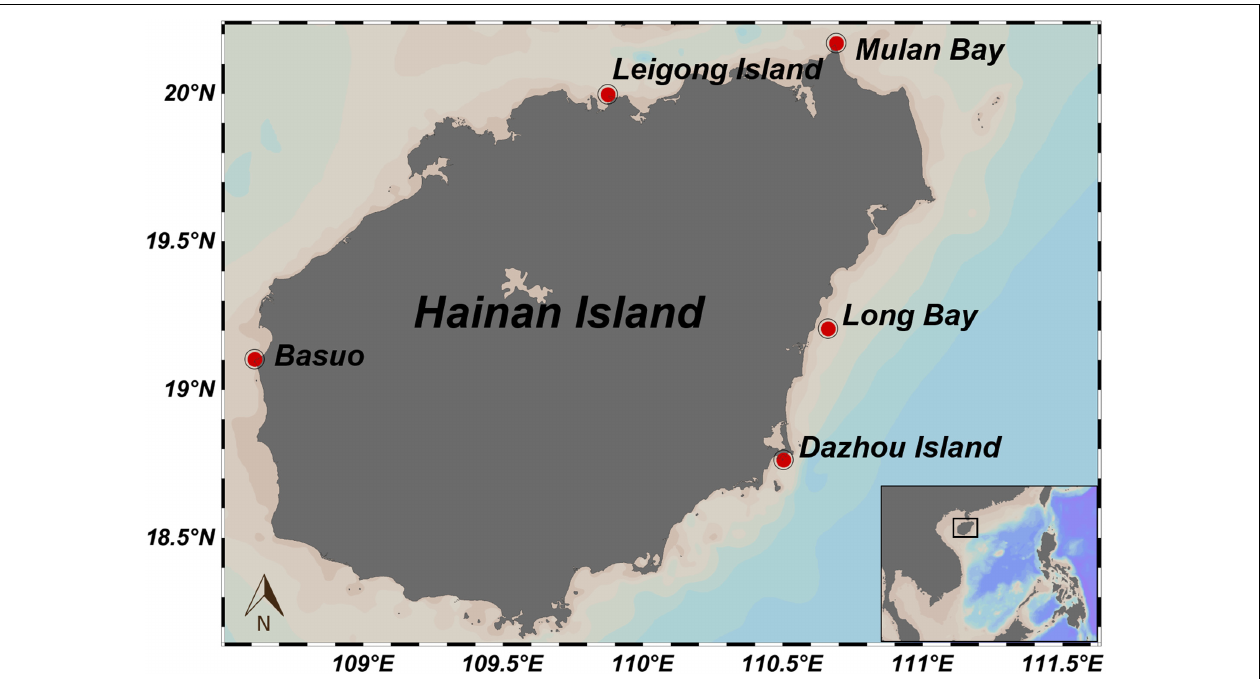
FIGURE 1 | A geographic map showing five sampling locations at Hainan Island, China. Red dots represent sampling sites.